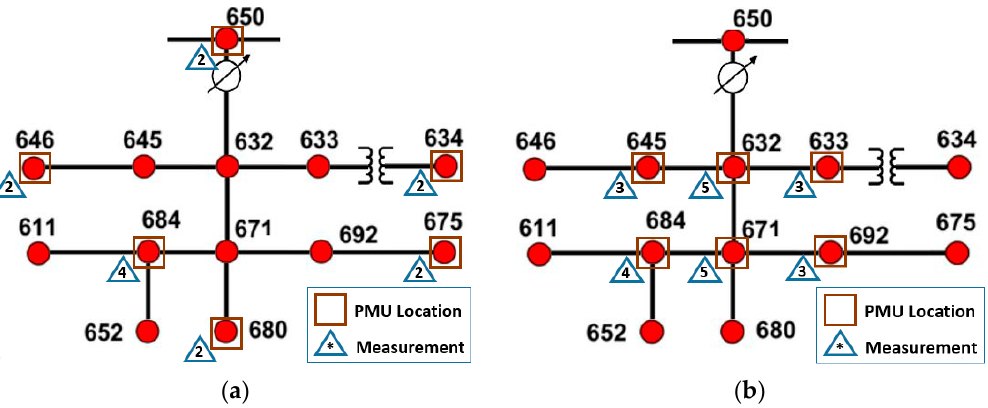
Figure 2. The BSA and MILP based PMU locations and achieved measurement redundancy. ( a ) MILP based PMU locations; ( b ) BSA based PMU locations.